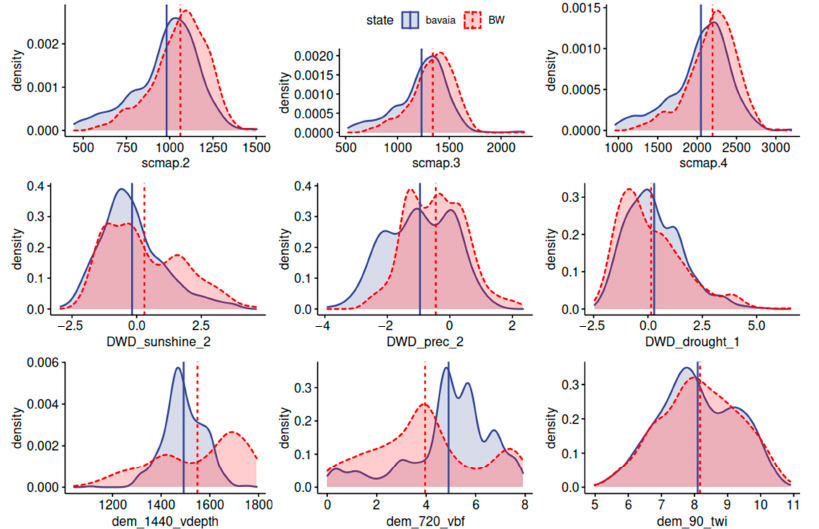
Figure 11. Multivariate Environmental Similarity Surfaces (MESS), calculated with the most important covariates and training samples of BW ( A ) and BY ( B ). Areas with high model uncertainty are colored in red. Black dots show sampling locations.